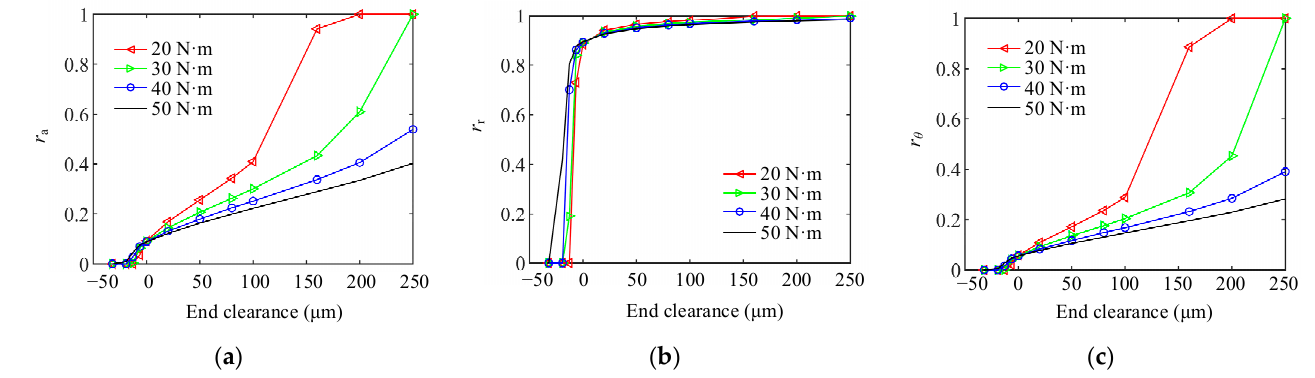
Figure 13. Effects of end clearance on the ratio of taper stiffness to the spindle–GWF interface stiffness at different tightening torques: ( a ) ratio of tapered axial stiffness to the spindle–GWF interface axial stiffness; ( b ) ratio of tapered radial stiffness to the spindle–GWF interface radial stiffness; ( c ) ratio of tapered angular stiffness to the spindle–GWF interface angular stiffness.